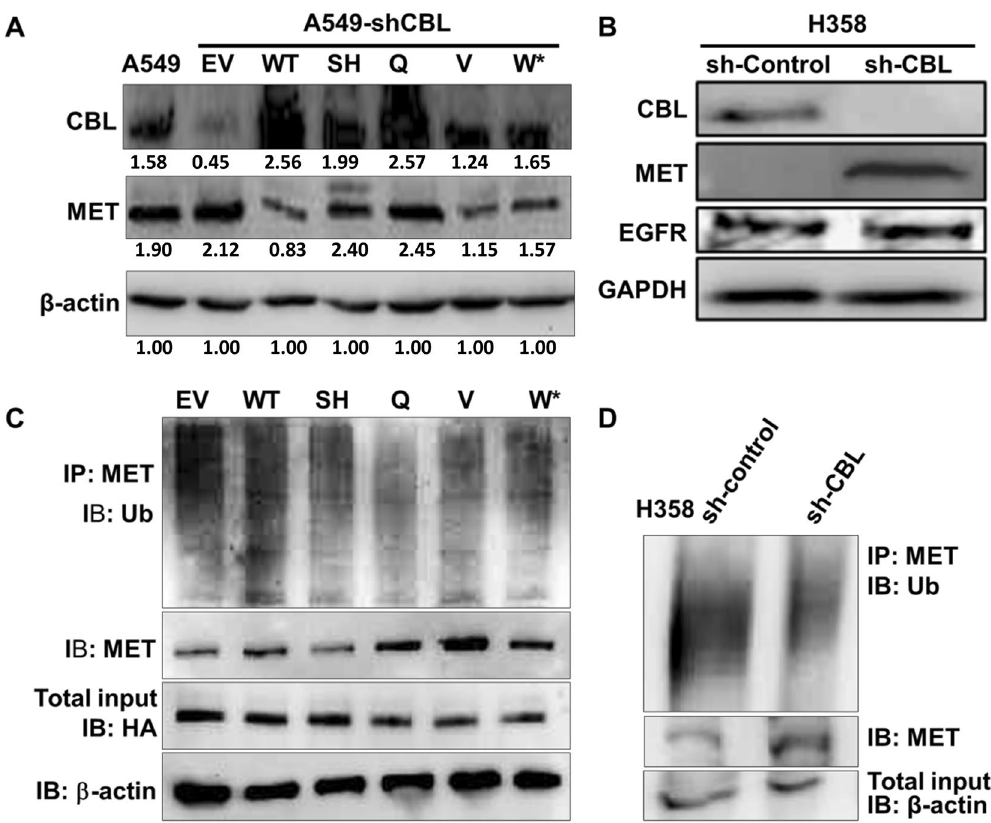
Figure 1. Ubiquitination and expression analysis of various CBL mutants. ( A ) A549 shRNA knockdown CBL cells were transiently transfected with various CBL mutants (SH: S80N/H94Y, Q: Q249E, V: V391I, W * : W802 * ) and wild-type (WT). MET protein showed low expression in CBL WT and high expression in CBL Mts isogenic cells. Protein expression was quantified and indicated with the fold change numbers shown below each immunoblot in comparison with loading control β -actin. ( B ) MET and EGFR expression of H358 sh- control and sh-CBL. MET showed higher expression in sh-CBL than sh-control cells. EGFR had no difference in sh-control and sh-CBL. ( C ) A549 cells transiently transfected with empty vector (EV) or CBL WT and Mts (SH: S80N/H94Y, Q: Q249E, V: V391I, W * : W802 * ). Whole cell lysates were IP with anti-MET antibody and IB with anti-Ub antibody. IB with anti-HA antibody for transfection efficiency and β -actin for loading control of the IP. The results showed the ubiquitination of MET were decreased in A549 cells that transiently expressed CBL mutants relative to CBL WT cells. ( D ) H358 sh-Control and sh-CBL cell lysates were IP with anti-MET antibody and IB with anti-Ub antibody β -actin for loading control of the IP. The results showed the ubiquitination of MET were decreased in sh-CBL cells relative to sh-control cells. Each protein lysates of separated blot of were collected in the same time period for and the lysates were loaded in one gel per antibody